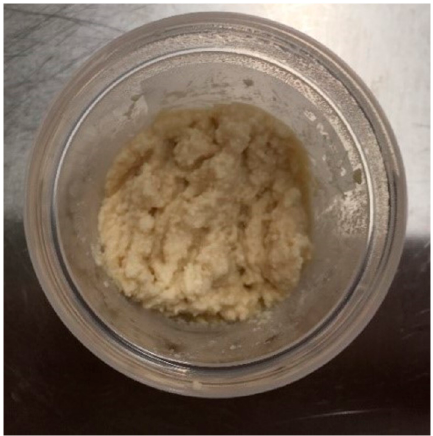
Figure 1. Photograph of the cheese spread produced incorporating Osmundea pinnatifida extract.